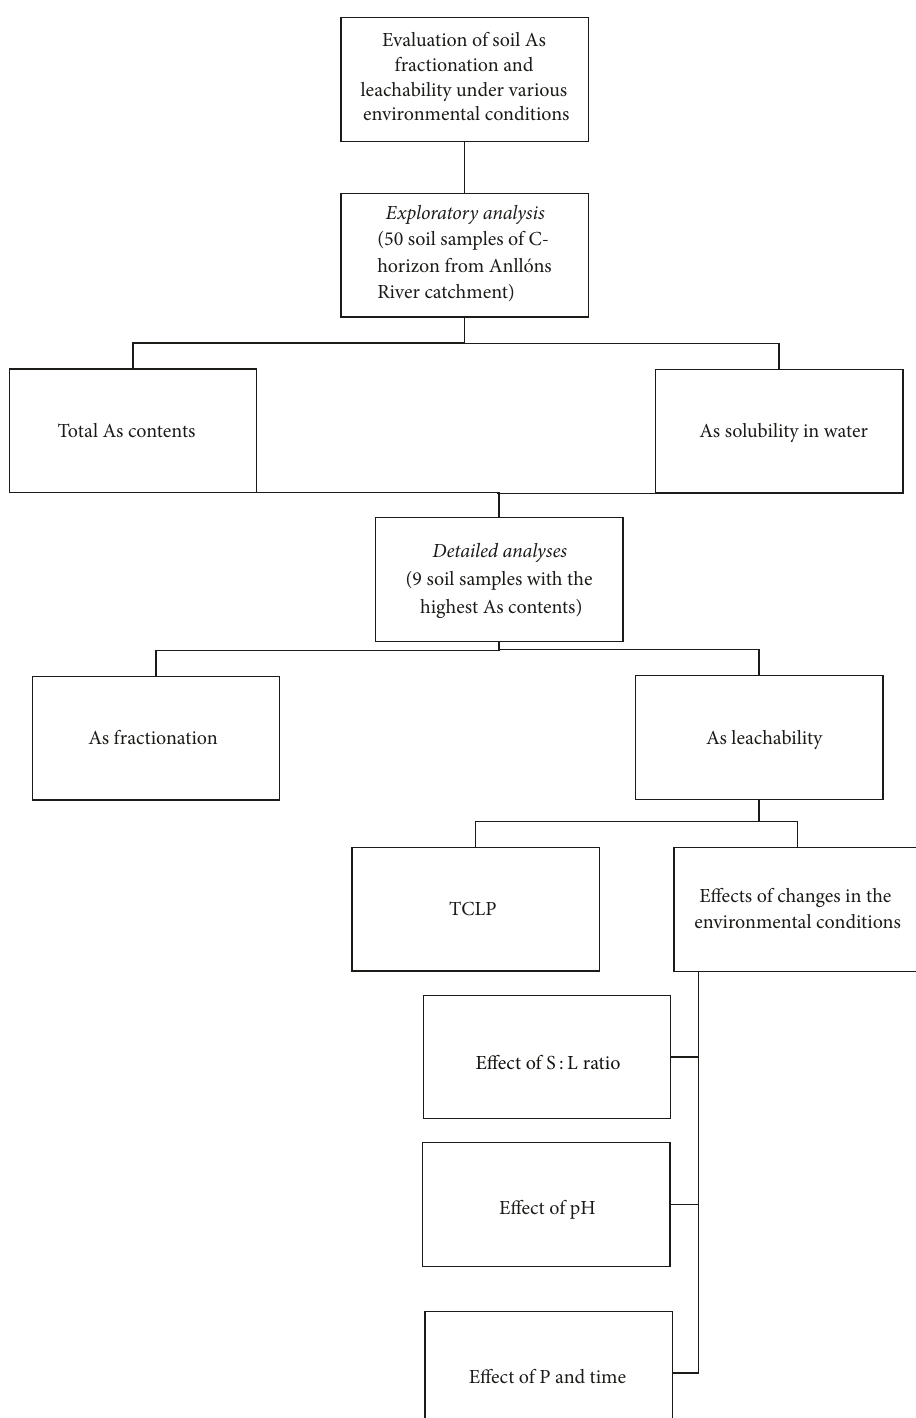
Figure 2: Scheme of the experimental